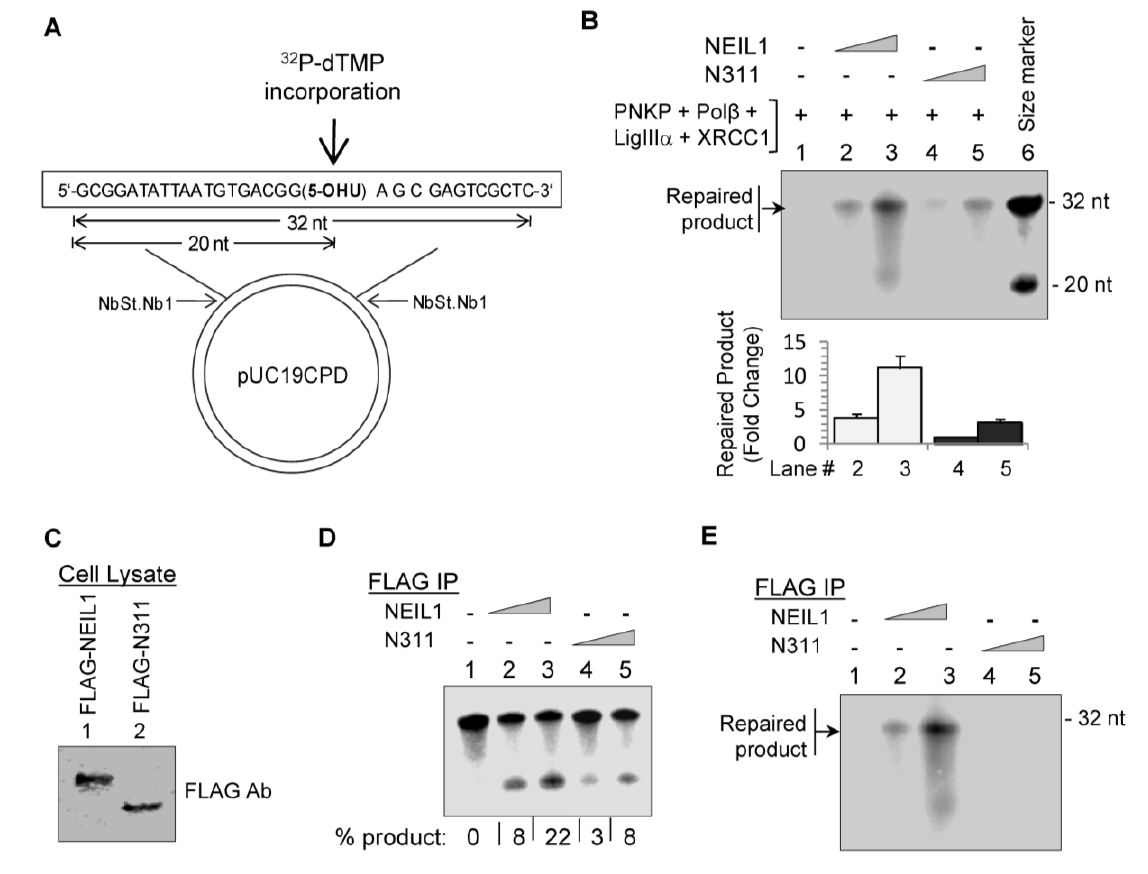
Figure 4. NEIL1’s CID is required for efficient repair of oxidized DNA lesions. (A) Repair of the 5-OHU-containing plasmid was monitored by the incorporation of 32 P-dTMP and analysis of a 32 nt Nt.BstNB1 restriction repaired fragment after denaturing gel electrophoresis [18,38]. (B) In vitro reconstitution of NEIL1-intitiated SN-BER with purified proteins (10 and 50 fmol WT NEIL1 [lanes 2 and 3] or N311mutant [lanes 4 and 5] and 50 fmol each of PNKP, Polβ, LigIII  and XRCC1). 5 ' - 32 P-labeled 32 and 20-mer oligos were used as size markers (lane 6). The histogram shows quantitation of repair. (C-E) FLAG-N311 IP, with reduced DNA glycosylase activity compared to FLAG-WT NEIL1 IP (D), was extremely deficient in overall repair (E). The DNA glycosylase activity was measured with 5-OHU-duplex oligo and complete repair with the plasmid substrate. FLAG levels in stably expressing cells were compared by Western analysis